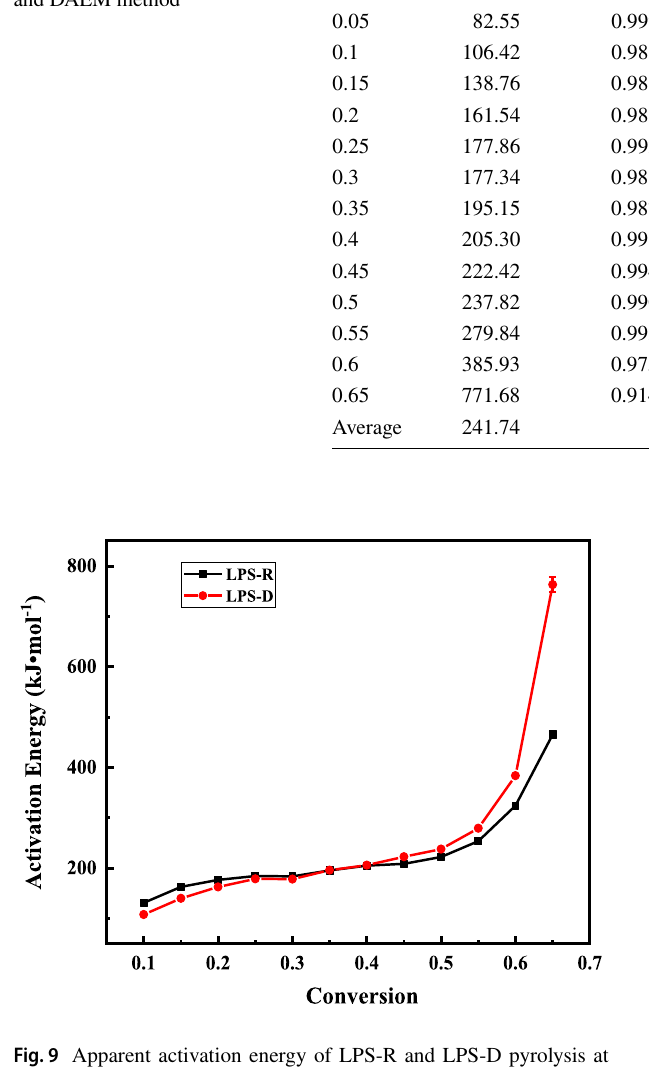
energy of LPS-R pyrolysis determined by Starink, FWO and DAEM method